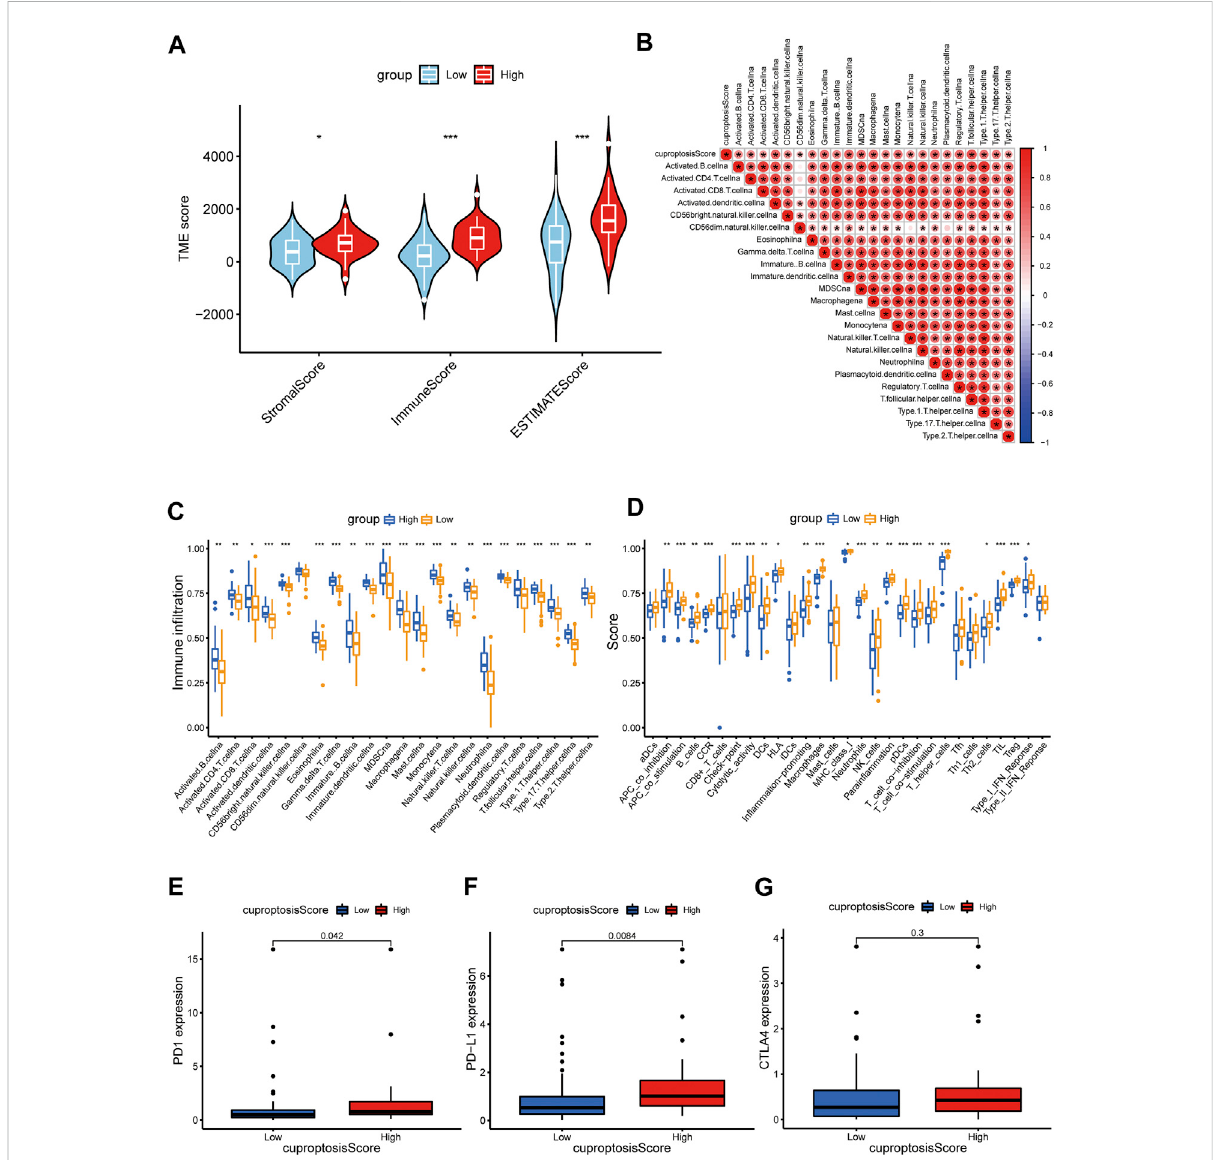
FIGURE 9 Distinct TME characteristics and mutation of OS patients according to the cuproptosis score. (A) Correlations between cuproptosis score and both immune and stromal scores. (B) Correlations between cuproptosis score and immune cells. Boxplots showed (C) abundance of 23 in fi ltrating immune cell types and (D) differences in immune scores in the two cuproptosis score groups. (E – G) The boxplots showed variations in the expression levels of PD1, PD-L1, and CTLA4 between the two cuproptosis score groups. ( p < 0.05 *; p < 0.01 **; p < 0.001